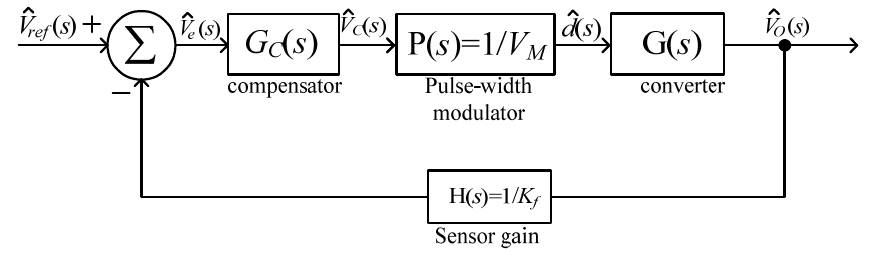
Figure 16. Block diagram of the closed-loop control system of the proposed